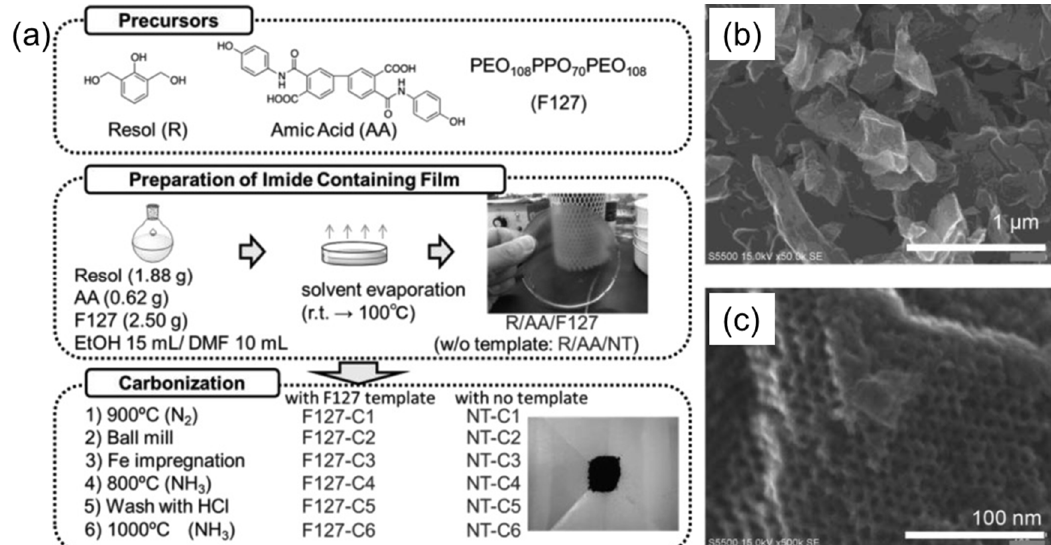
Figure 12. ( a ) Block copolymer-templated carbonization of a nitrogen–containing polymer to create mesoporous carbon for oxygen reduction catalyst. ( b , c ) SEM images of F127-C6 mesoporous carbon, taken at different magnifications. Adapted from [33].